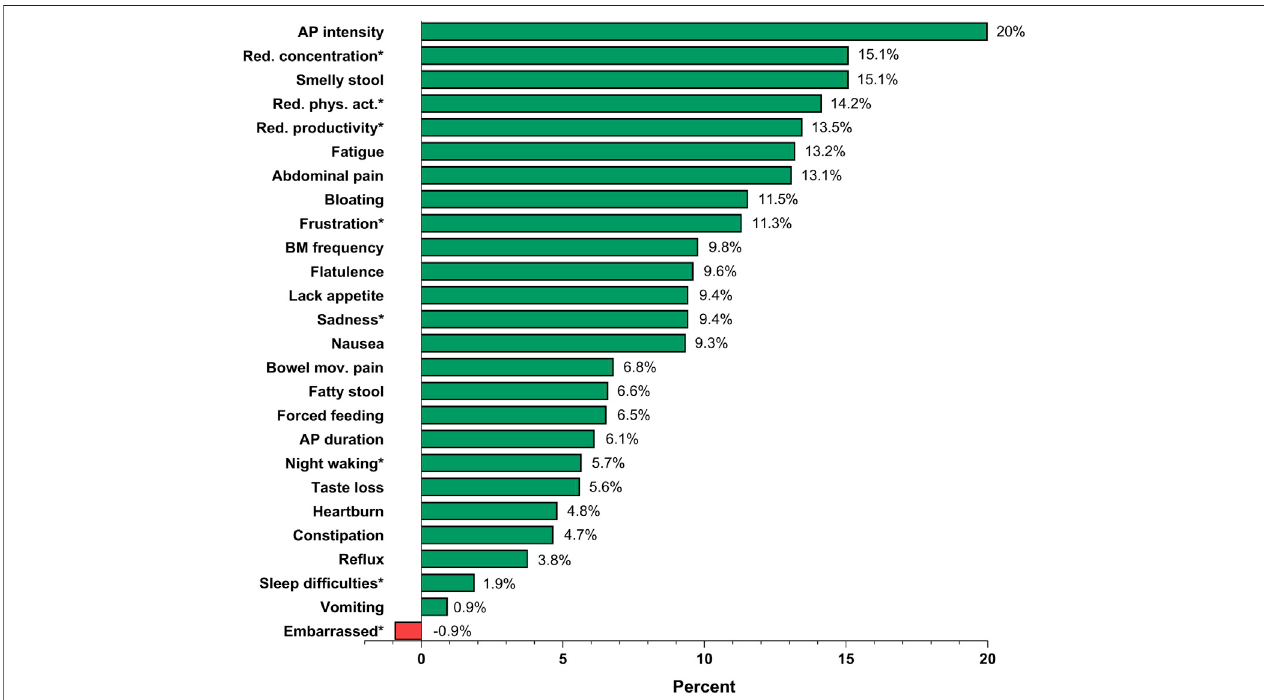
FIGURE 3 | Pre/Post-ETI differences in responses for single items included in the CFAbd-Score from 107 pwCF during treatment with Elexacaftor-Tezacaftor- Ivacaftor (ETI). Percentages of patients reporting each symptom at least occasionally (2 – 3 times during the past 2 weeks) are listed. Stool colour and stool consistency, as parts of the modi fi ed Bristol stool scale, were excluded. For frequency of bowel movement, changes regard those reporting at least 2 – 3 stools/day. AP: abdominal pain; Bowel mov: bowel movement; Red. phys.act: Reduced physical activity. *Items regarding quality of life were assessed as relating to abdominal symptoms.